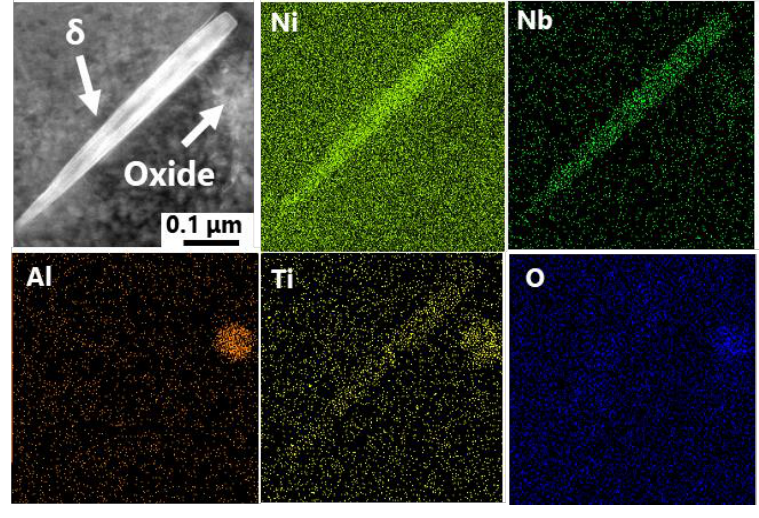
Figure 5. EDS mapping of Ar-SLM HT specimen.